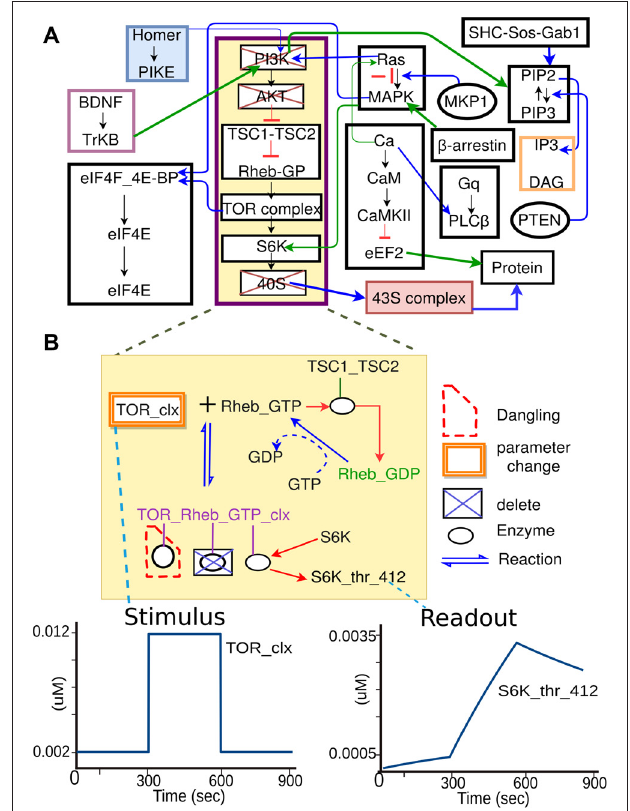
FIGURE 4 | Specification of model sub-parts. (A) Original full model, from which a few pathways are selected. (B) Further selections of reactions from the subset of pathways. Deleted molecules, reactions, and enzymes are indicated by boxes with blue crosses. In some cases, deleting molecules leads to dangling reactions (red dashed boundary), which lack one or more reactants. The system identifies these. In addition to removal of extraneous reactions and reactants, the experiment specification may involve alteration of parameters, such as the concentration of a molecule that is buffered in the experiment. This is illustrated as orange boxes around the molecule TOR_clx. Finally, the model specification also defines the mapping between the experimental names for stimulus or readout molecules, to the corresponding names for these molecules as used in the